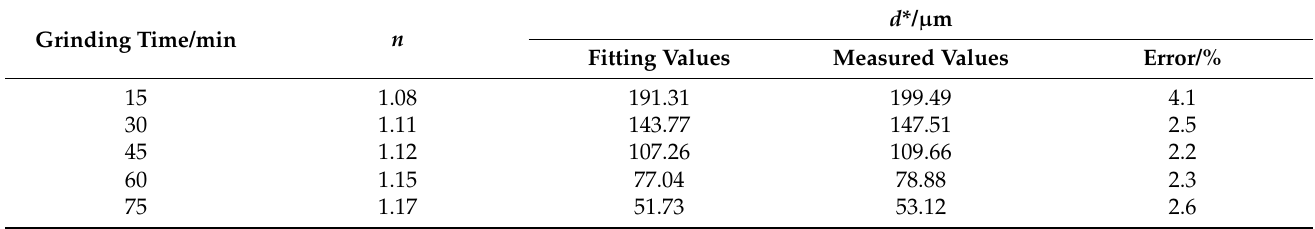
Figure 6. Fitting curve of RRB distribution model of CGS with different grinding time. Table 4. Fitting parameters of RRB distribution model of CGS with different grinding time.